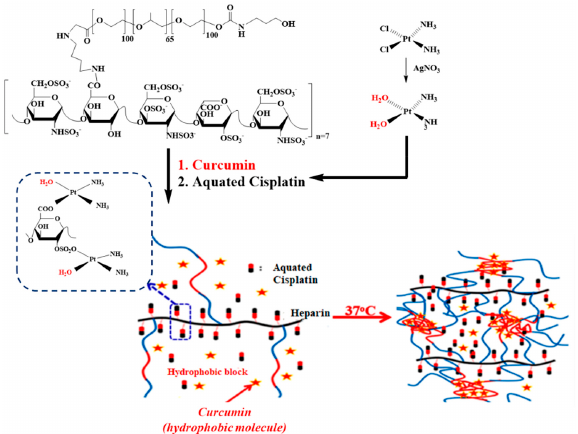
Figure 1. Thermosensitive dual drugs delivery nano-platform Hep-F127/CDDP/Cur (with CDDP being aquated